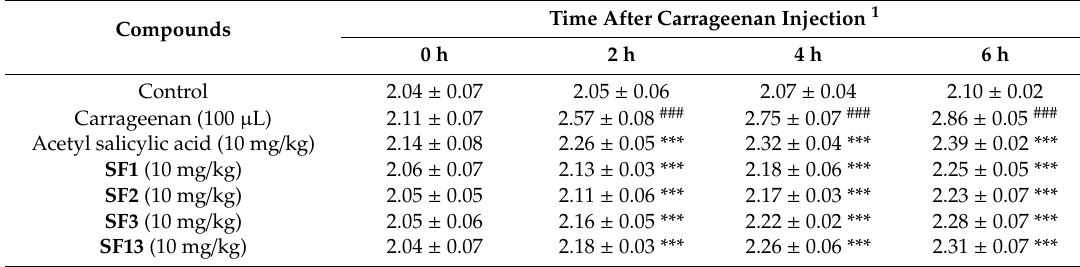
Table 7. E ff ect of acute treatment of synthetic compounds (10 mg / kg) on carrageenan-induced inflammation ( n = 5).